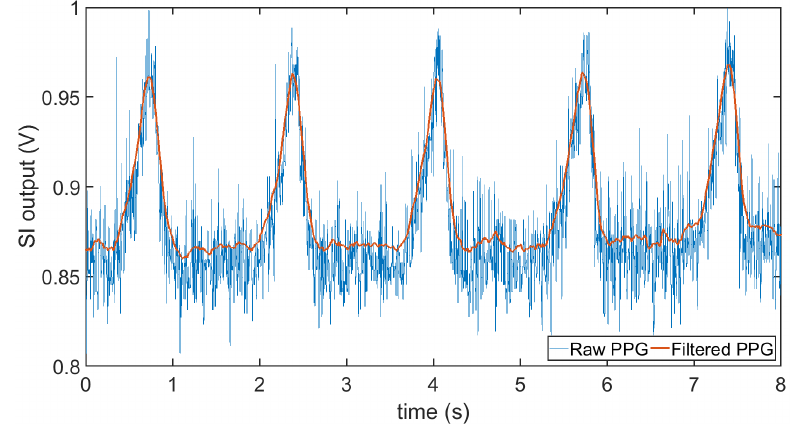
Figure 14. The raw signal from the output of the switched integrator and the filtered signal after performing a moving average when using the presented PPG readout circuit during the rat experiment demonstrating a more pronounced respiratory pattern and buried heart